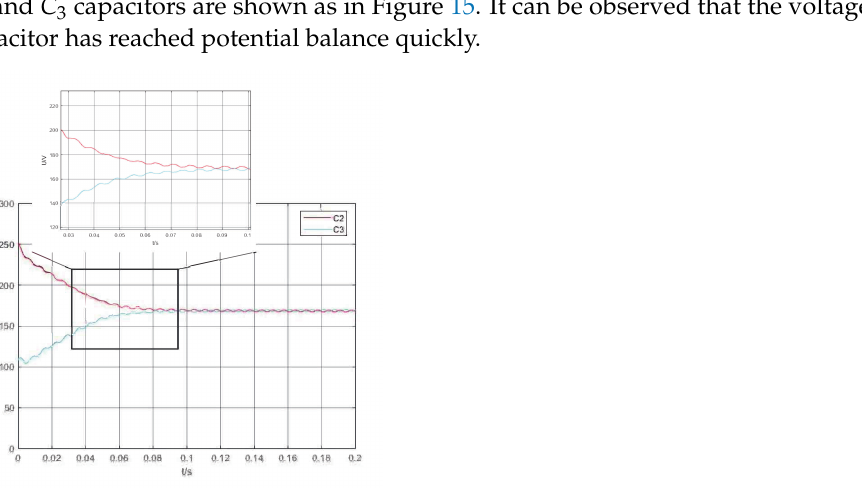
Figure 15. Voltage waveform of upper and lower capacitors under neutral point voltage control.